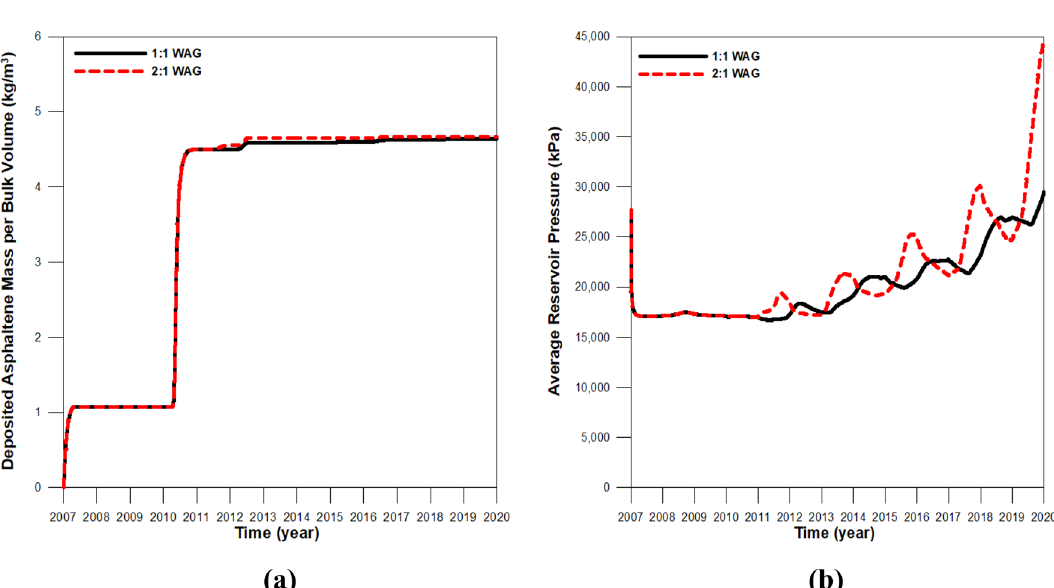
Figure 16. ( a ) The amount of asphaltene deposition per bulk volume in the middle of the reservoir and ( b ) the average reservoir pressure with different WAG ratios.